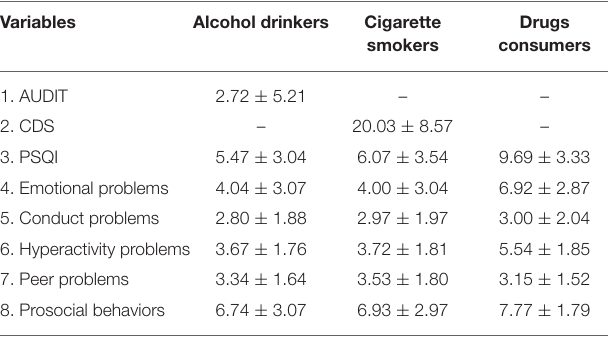
TABLE 2 | Descriptive scores of all psychometric tests across different respondent